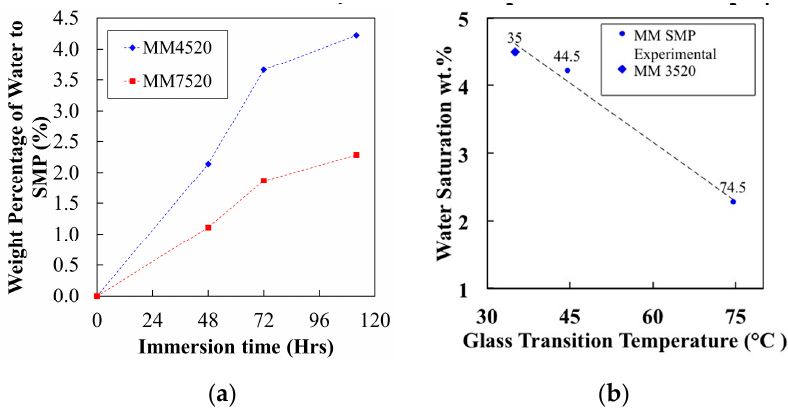
Figure 5. ( a ) Ratio of water content to MM4520 and MM7520 after different immersion times in water ( b ) water Saturation with respect to Shape Memory Polyurethane Tg series.